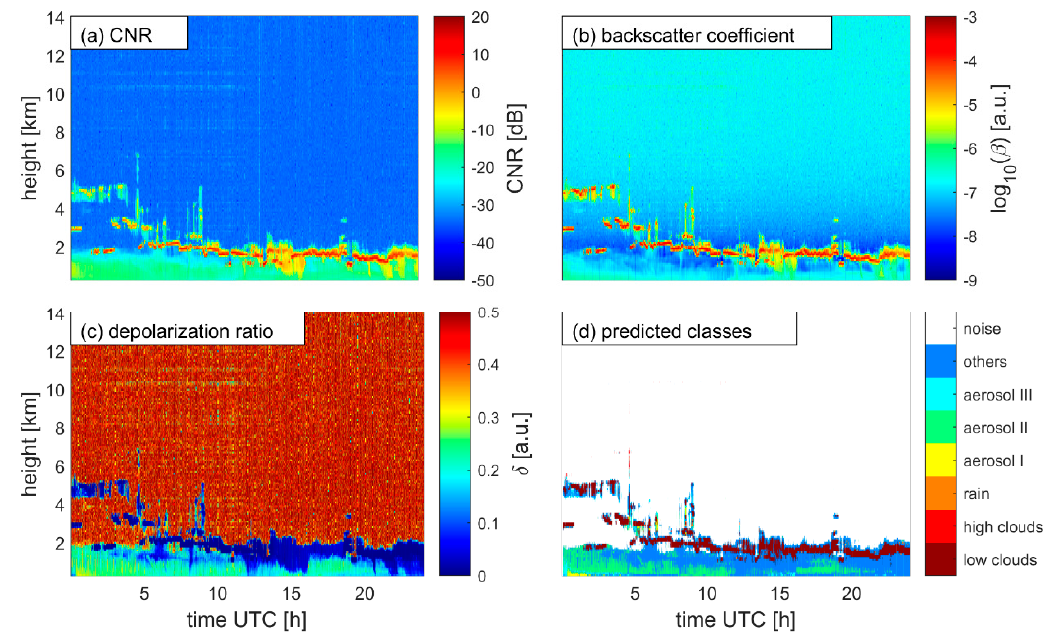
Figure 9. The case with the data not used for model training: the lidar measurements on 10 July 2019, at Reykjavik ( a ) CNR, ( b ) backscatter coefficient, ( c ) depolarization ratio and the machine learning classification result ( d ) predicted classes.